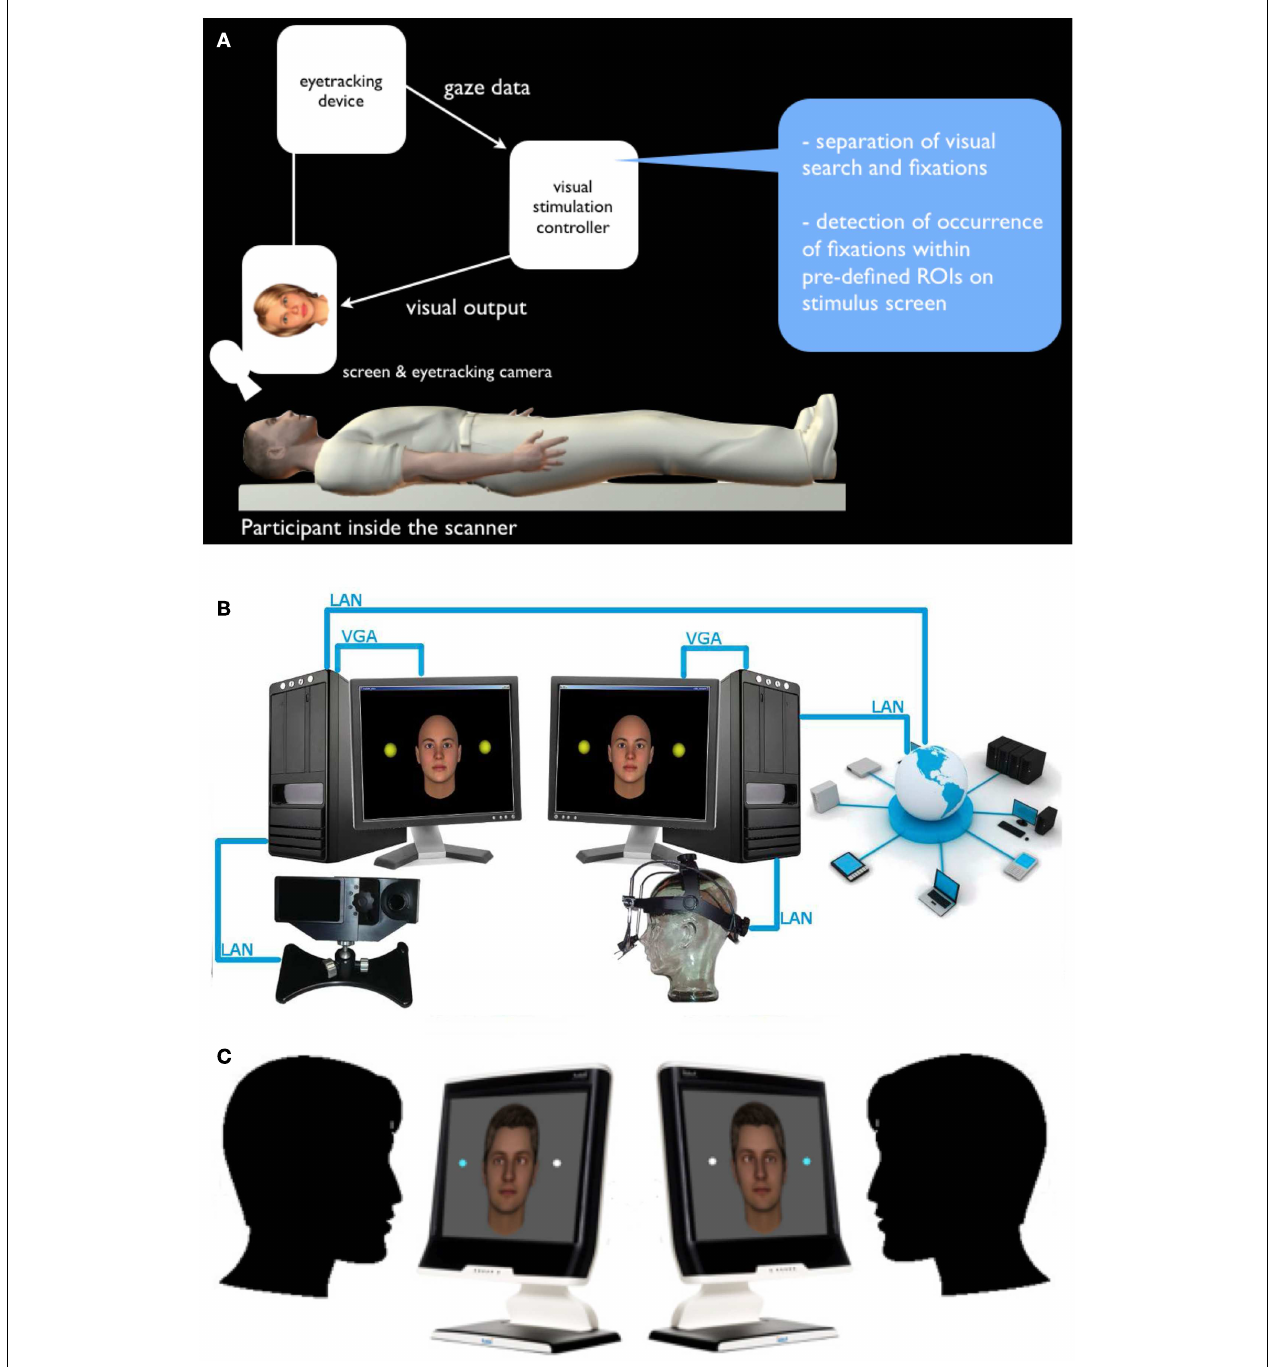
mediated gaze-based interaction (each participant is represented by a virtual character for the respective other). (C) Two participants engaged in a two-person perceptual decision-making task, in which both are asked to discriminate stimuli while the gaze behavior of the respective other participant is visualized on the stimulus screen as well. Importantly, people do not just see where the other is looking via cursor or similar, but actually experience the other’s gaze, to which they can dynamically